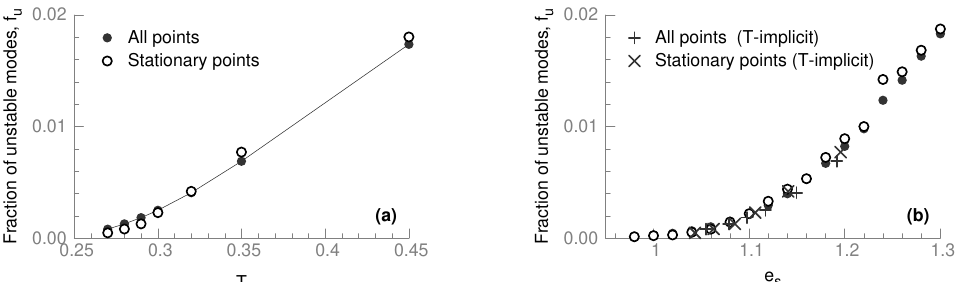
Figure 9: Fraction of unstable modes in all points and in true stationary points ob- tained from W -minimizations as function of (a) temperature and (b) energy. In panel (b) we show both averages on a per-energy basis (circles) and using T as an implicit variable (crosses). The number of particles is N =